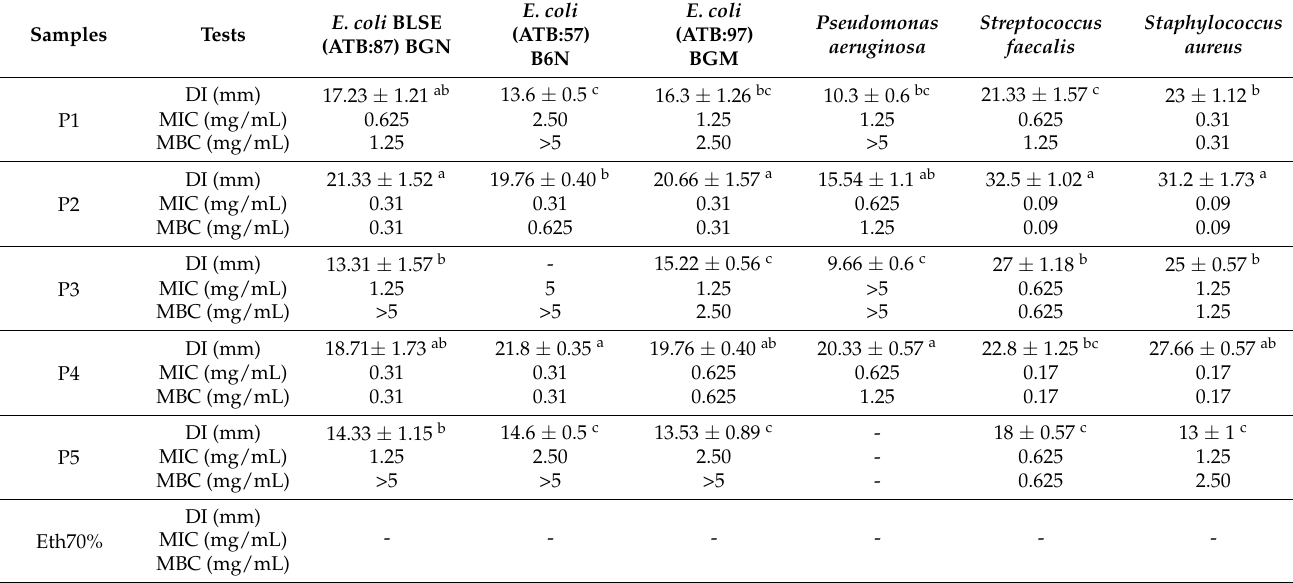
Table 5. Results of the antibacterial activity of propolis samples.